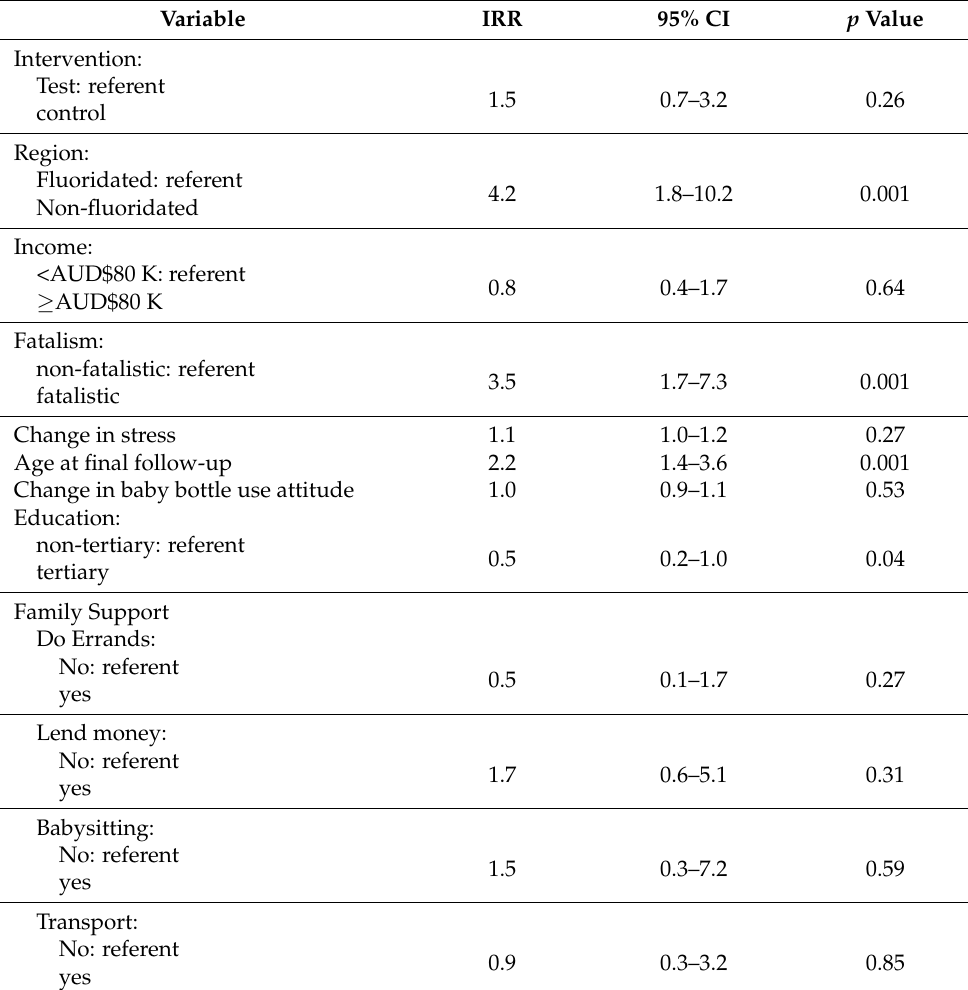
Table 5. Multivariable negative binomial regression model, coefficients presented as incident rate ratios (IRR) for the count of caries experience (dmfs; decayed, missing and filled surfaces) controlling for variables with p < 0.35 in univariable negative binomial regression. Variable IRR 95% CI p